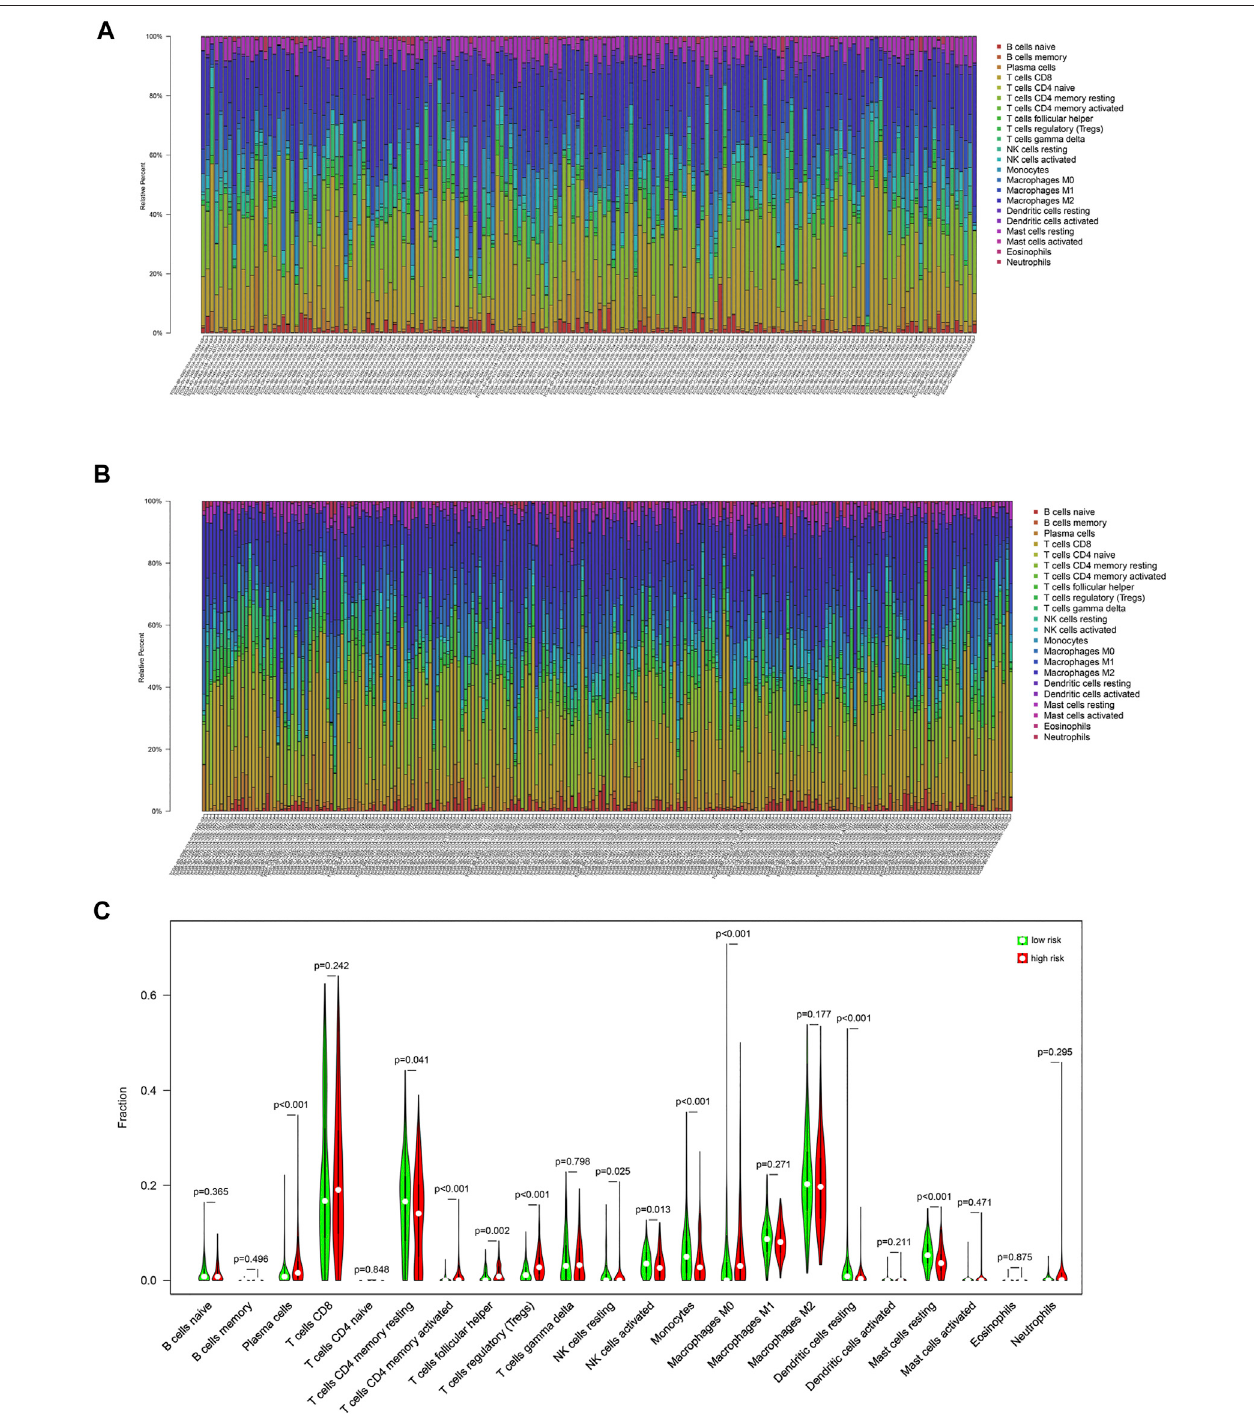
FIGURE 4 | Immune cell in fi ltration signatures of each group. (A) The immune cell in fi ltration signatures in the low-risk group. (B) The immune cell in fi ltration signatures in the high-risk group. (C) Differences in immune cell in fi ltration characteristics between low-risk and high-risk populations.